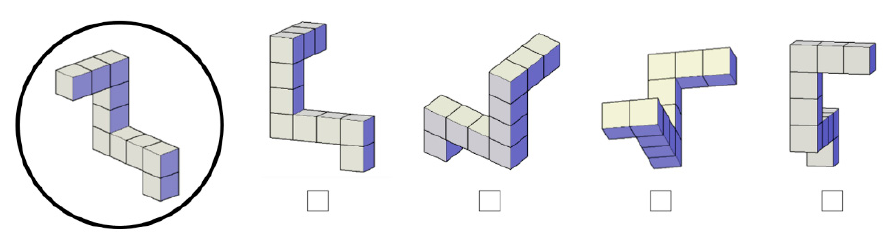
Figure 3. Example item in the Mental Rotation Test (MRT).